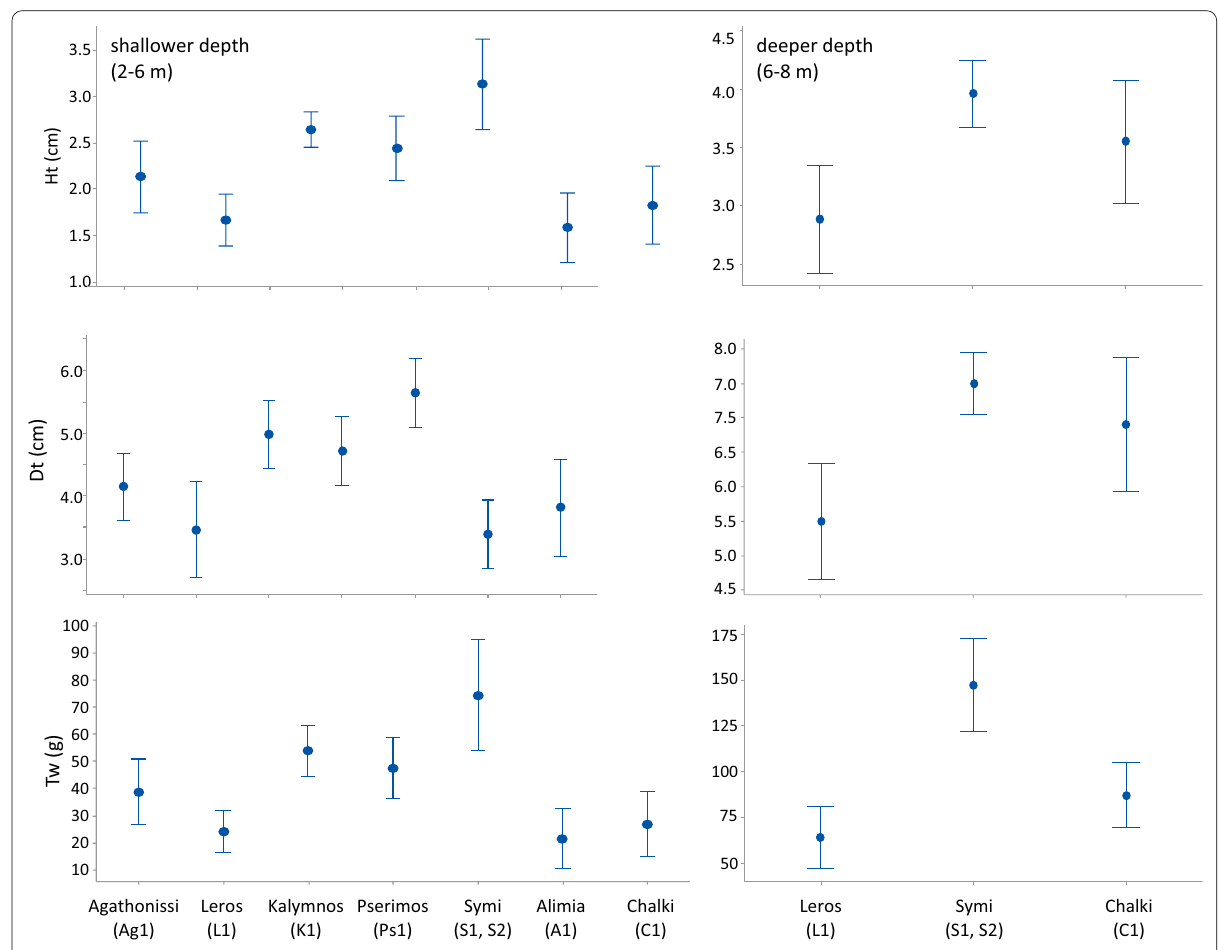
Fig. 4 Mean size (Ht test height, Dt test diameter) and biomass (tW = = (A, C or F relative abundance grade) islands in the shallower (left) and lower (right) depth distribution of the